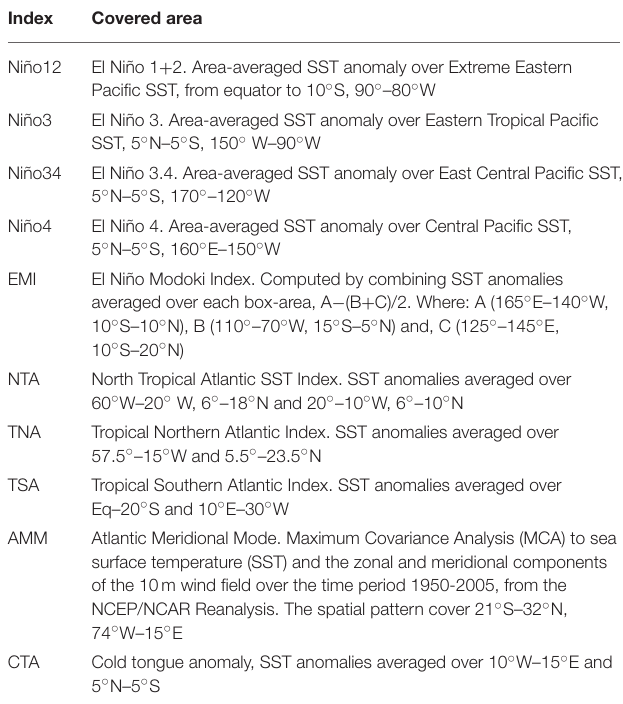
TABLE 1 | ENSO and Atlantic indices and respective regions of SST anomalies. Index Covered